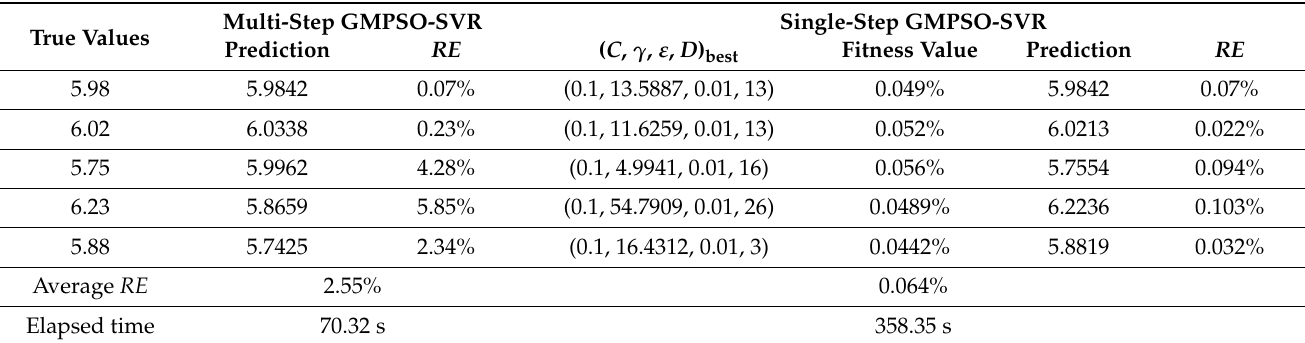
Table 4. Comparison between multi-step and single-step predictions.